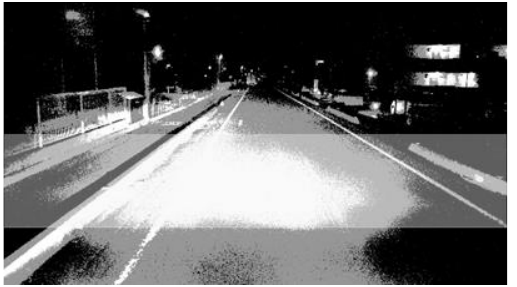
Figure 10 . Trimming range (without calibration).